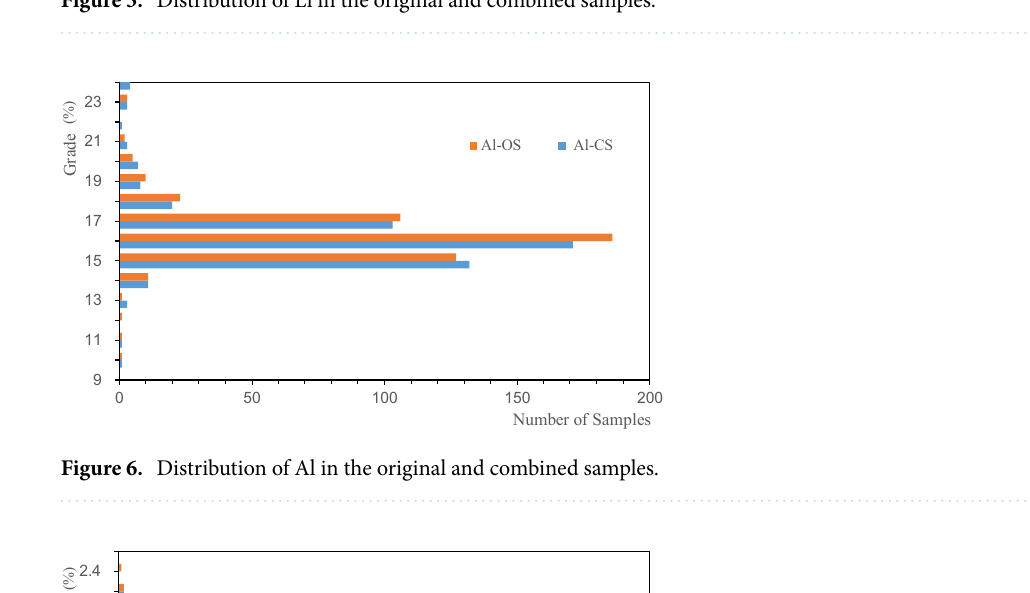
Figure 5. Distribution of Li in the original and combined samples.